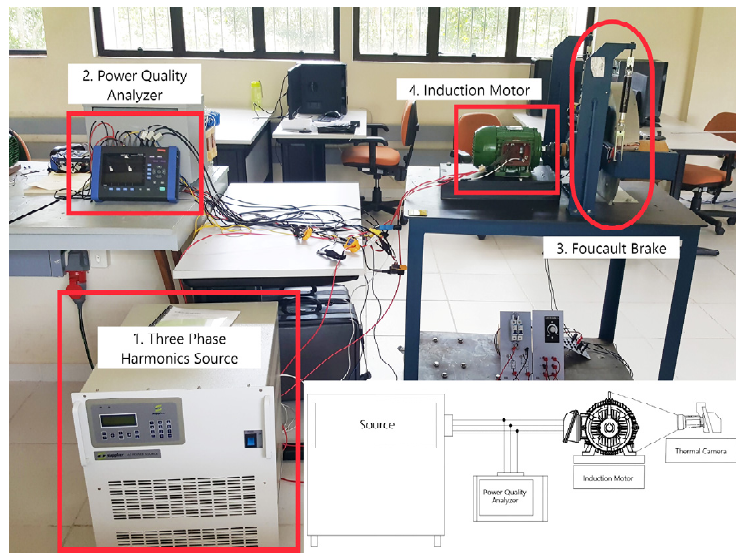
Figure 4. General test setup [8]. Table 1. Line-start Permanent Magnet Motor Parameters.